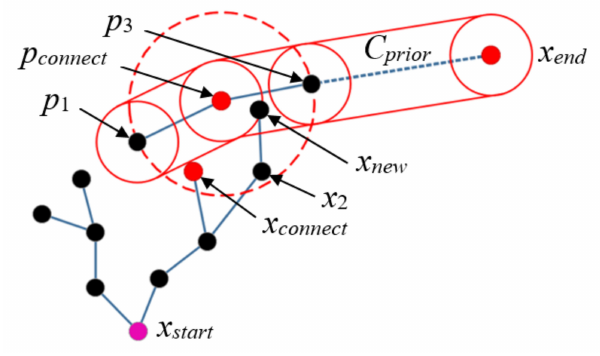
Figure 10. Selection of the nearest exploring